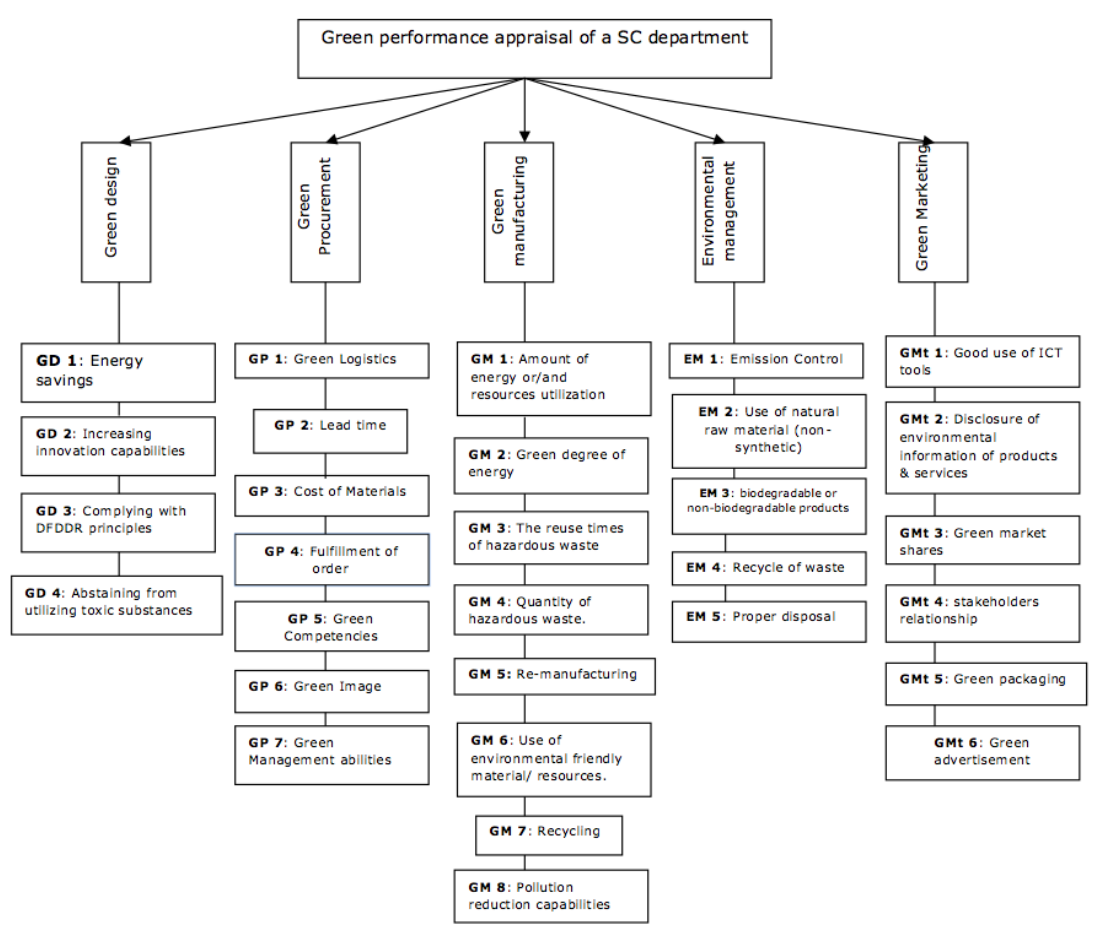
Figure 1. The hierarchical and appraisal